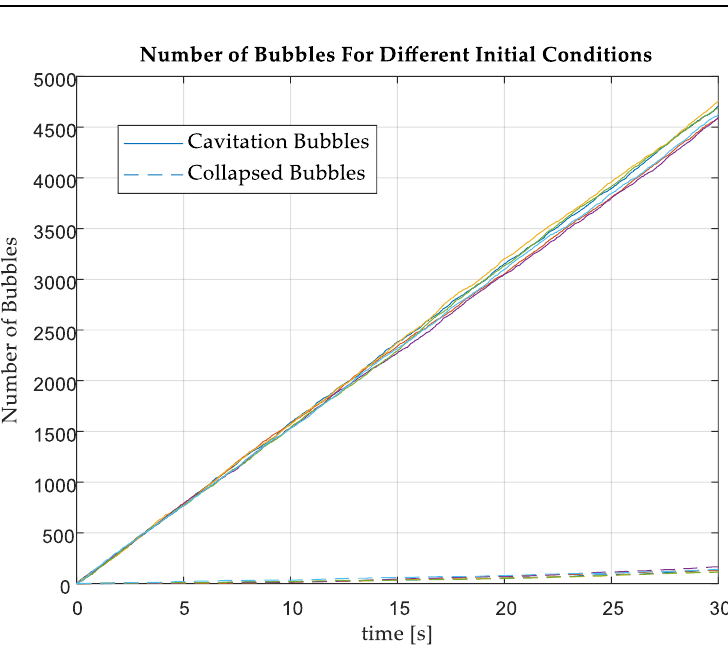
Figure 8. Simulation 4: Number of bubbles with a change in the initial conditions.